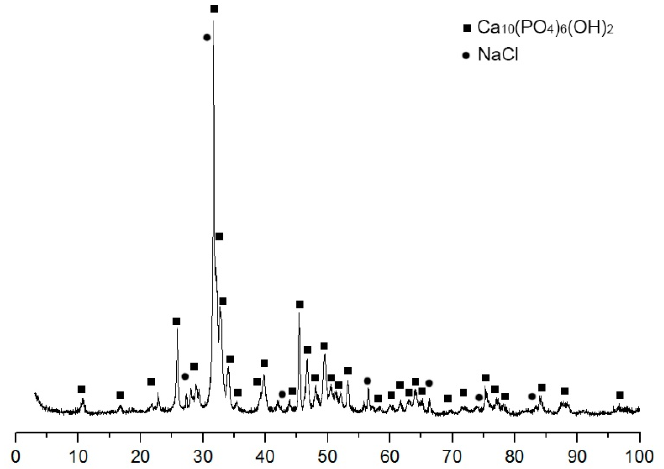
Figure 1. Diffraction pattern of the initial mixture of HA 75 wt.% and NaCl 25 wt.%. The content of NaCl in the samples ranged from 10 to 50 wt.%. The HA-NaCl ratios are shown in Table 1. Table 1. Composition of porous frameworks of materials based on hydroxyapatite and sodium chloride.